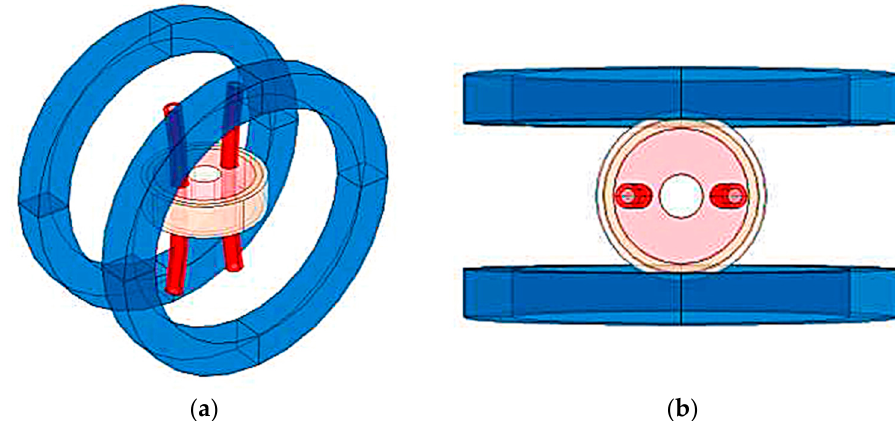
Figure 4. The basic model of simulation measurement: ( a ) 3D view; ( b ) X-Y plane view.